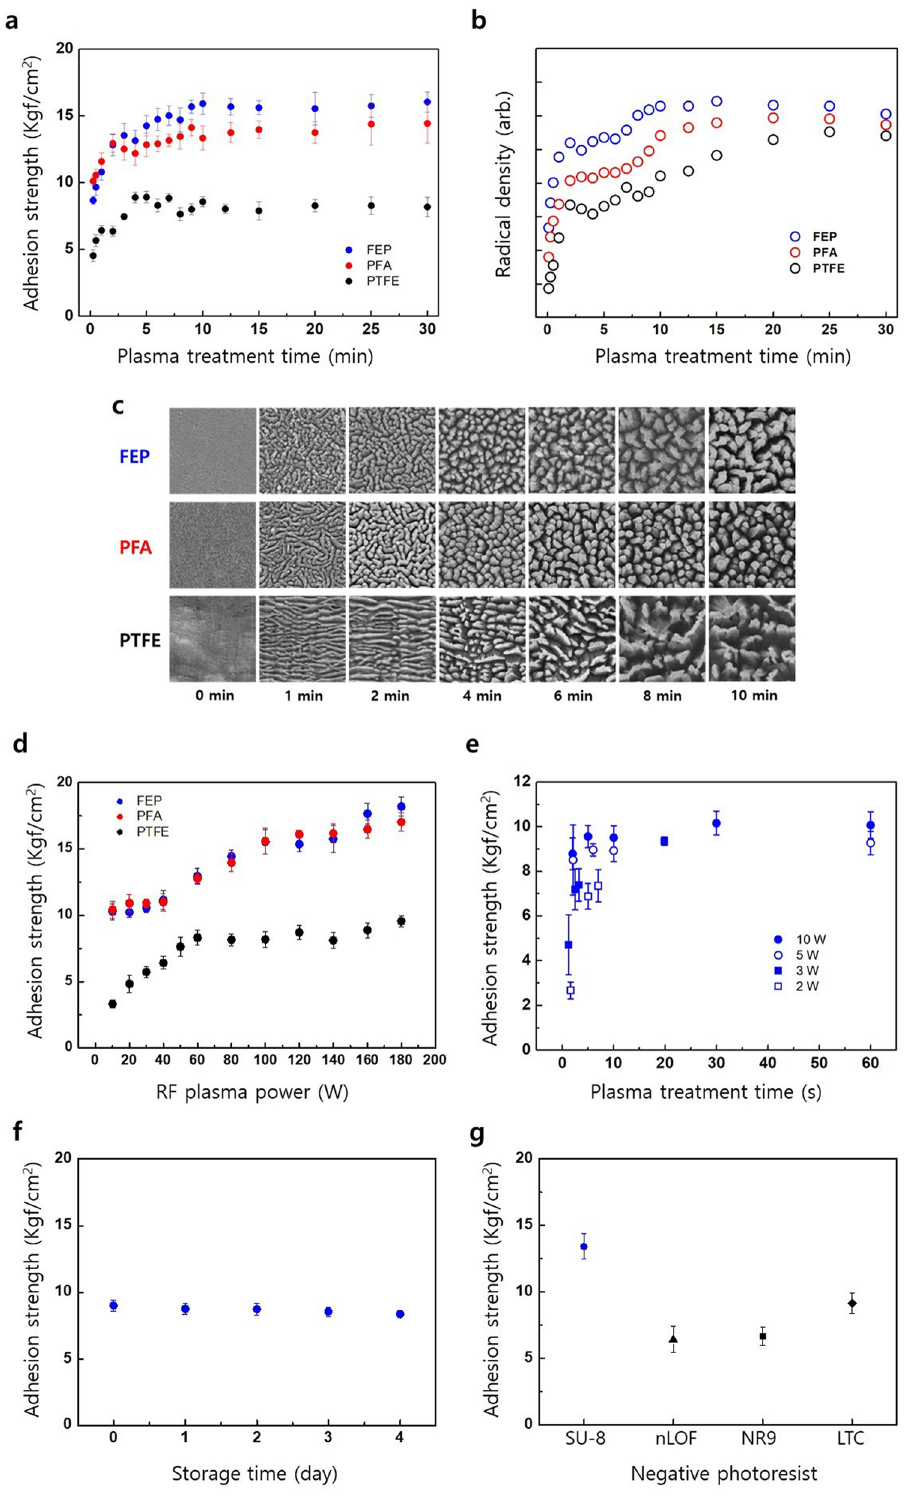
Figure 2. Effects of Ar RF plasma treatment (RF power: 40 W, working pressure: 15 mTorr) time ( a ) on the AS between SU-8 and fluoropolymers and ( b ) on the radical density of fluoropolymers. ( c ) FESEM surface images of FEP (top), PFA (middle), and PTFE (bottom) after various plasma treatment times. The dimension of each image is 2 μm × 2 μm. ( d ) Effect of Ar RF plasma power on the AS between SU-8 and fluoropolymers (plasma treatment time: 1 min). ( e ) The AS between SU-8 and plasma-treated FEP under milder conditions and plasma treatment times. Plasma treatment conditions are listed in the legend. ( f) The AS between SU-8 and plasma-treated FEP (RF power: 10 W, plasma treatment time: 1 min) with respect to the storage time in units of days. ( g) The AS of commercial negative photoresists with plasma-treated FEP (RF power: 40 W, RF plasma treatment time: 4 min). nLOF, NR9, and LTC denotes AZ nLOF 2070 (AZ), and NR9-3000PY (Futurrex), and LTC 9520 (FujiFilm),